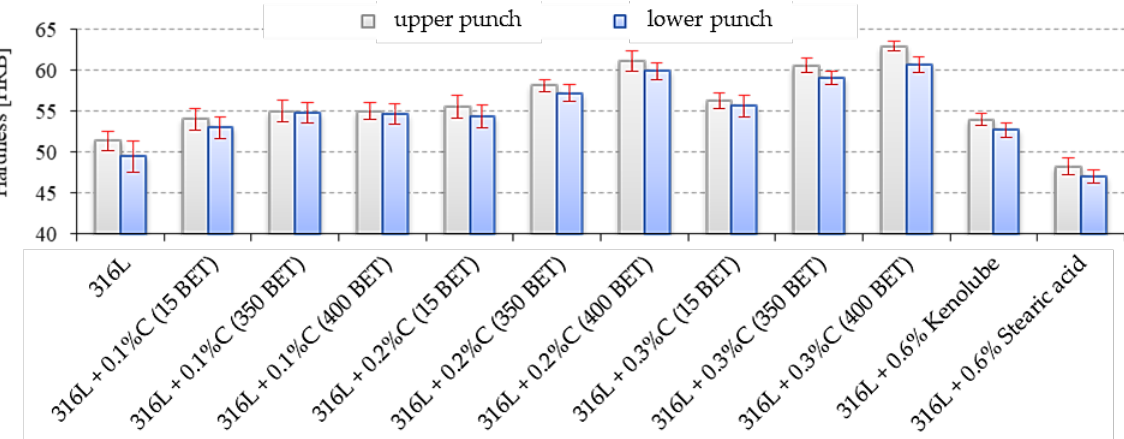
Figure 11. Rockwell hardness B scale of sinter, measured from the upper and lower punch side, depending on the percentage composition of the tested mixtures.